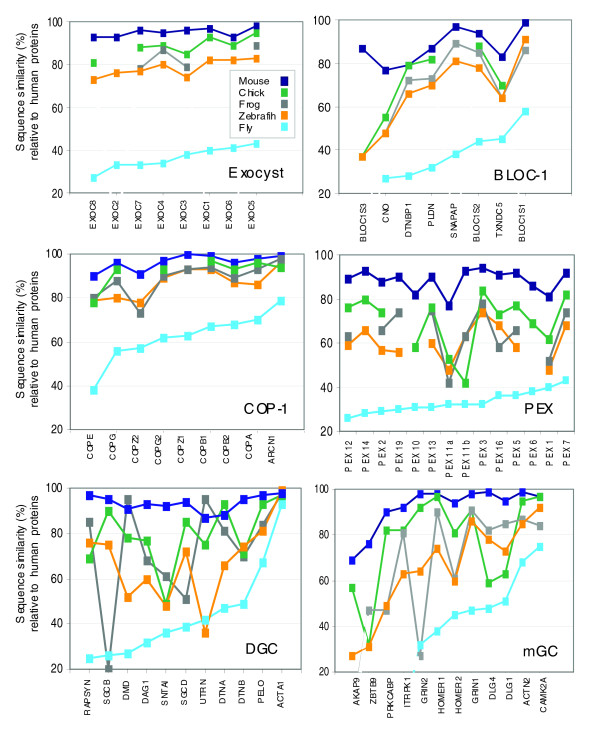
Evolution conservation among components of synaptic complexes. Conservation is measured by sequence identity (y-axis [%]) between human and five species: mouse (Mus musculus; dark blue), chicken (Gallus gallus; green) frog (Xenopus laevis; gray), zebrafish (Danio rerio; orange), and fly (Drosophila melanogaster; light blue). Data are sorted according to human-fly conservation. The conservation of each component in the complexes is shown. Shown are findings regarding the synaptic complexes that are associated with functional organization of the postsynaptic membrane: exocyst (EXOC; eight proteins; see Figure 2a), coatomer protein (COP)-1 (nine proteins; see Figure 3a), biogenesis of lysosome-related organelles complex (BLOC)-1 (eight proteins; Figure 2b); peroxisome biogenesis (PEX; 14 proteins); dystrophin glycoprotein complex (DGC; 11 proteins); and metabotropic glutamate receptor (mGC; 12 proteins). Note that the conservation range for fly proteins of the DGC and mGC spreads on a broad range, and for these complexes the conservation along the evolution tree is poorly coordinated.